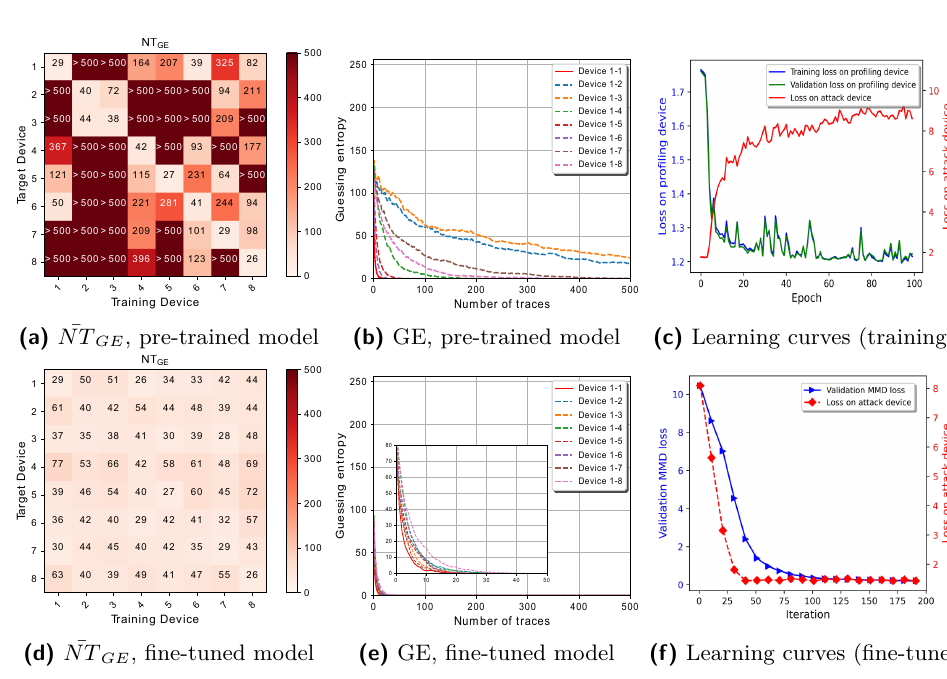
Figure 13: Results on XMEGA_EM.